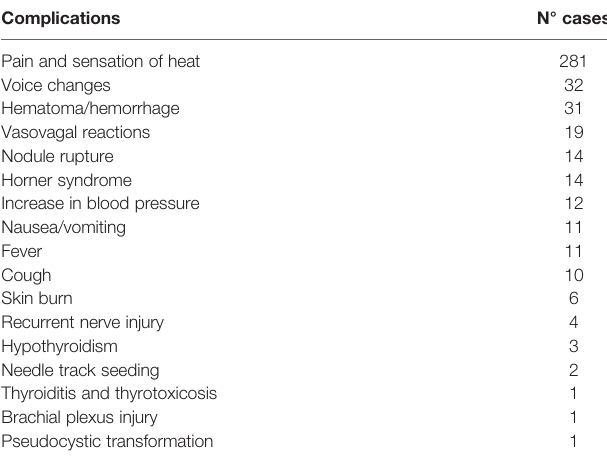
TABLE 1 | Complications following RFA of benign thyroid nodules [from a systematic review of 3409 patients by Wang et al. (101)]. Complications N° cases Pain and sensation of